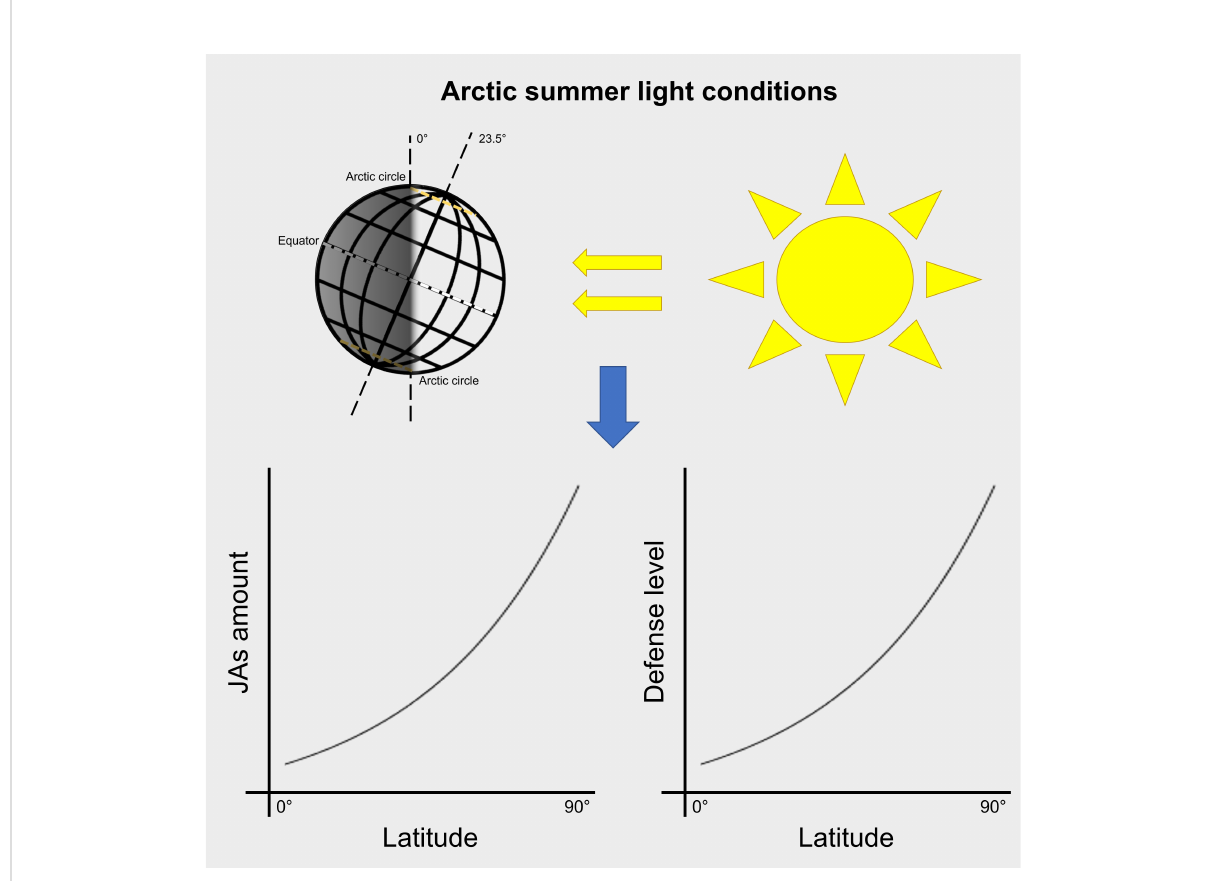
FIGURE 5 Model summarizing the suggested impact of arctic summer light conditions on jasmonates (JAs) and plant